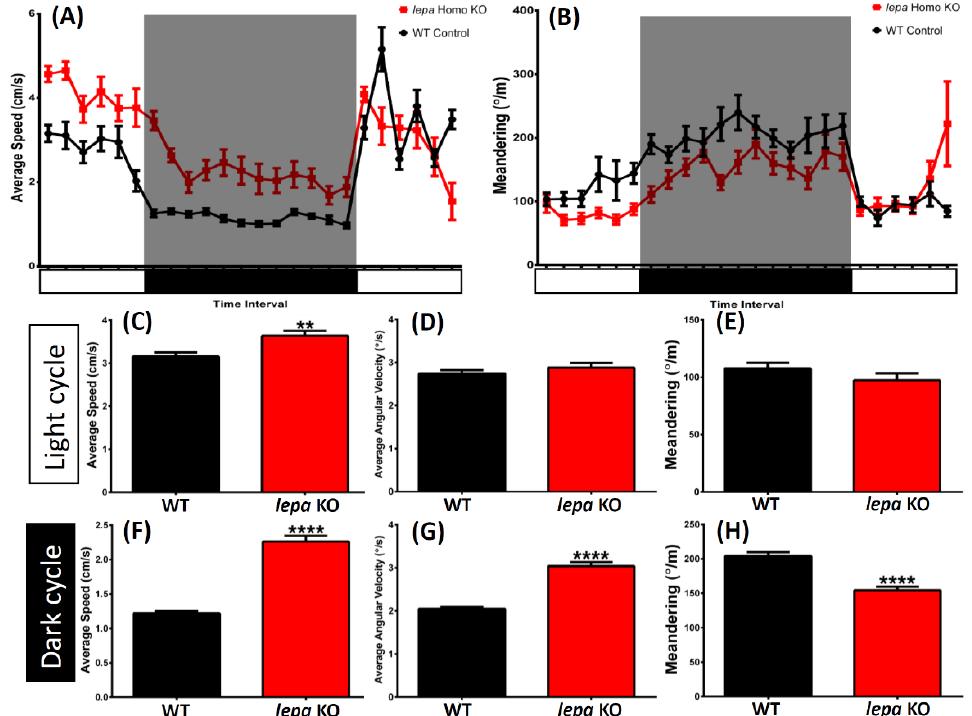
Figure 5. Comparison of several untreated wild type and lepa KO zebrafish behavior endpoints in circadian rhythm test: ( A ) circadian patterns of average speed; and ( B ) meandering in light/dark cycle. ( C ) Average speed; ( D ) average angular velocity; and ( E ) meandering during light cycle. ( F ) Average speed; ( G ) average angular velocity; and ( H ) meandering in during dark cycle. The data are expressed as the mean ± SEM and several data were analyzed by unpaired t-test ( n control = 30; n lepa KO = 16; ** p < 0.01, **** p < 0.0001).